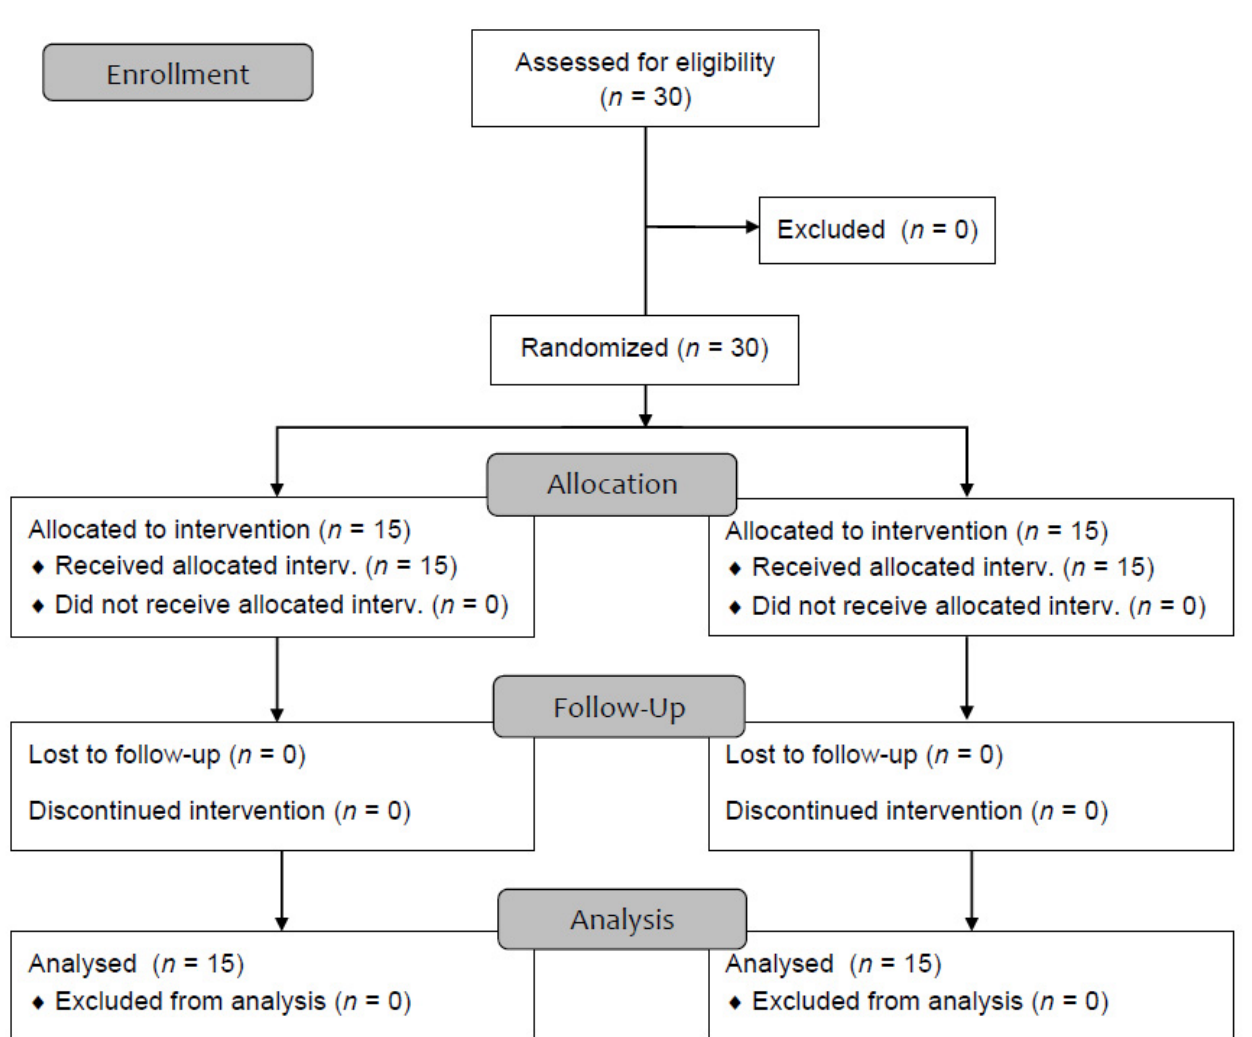
Figure 1. A CONSORT randomized trial flow chart. Table 2. Baseline clinical characteristics and biocompatibility parameters in both groups. Data are presented as frequency (percentage) or mean ± standard deviation.